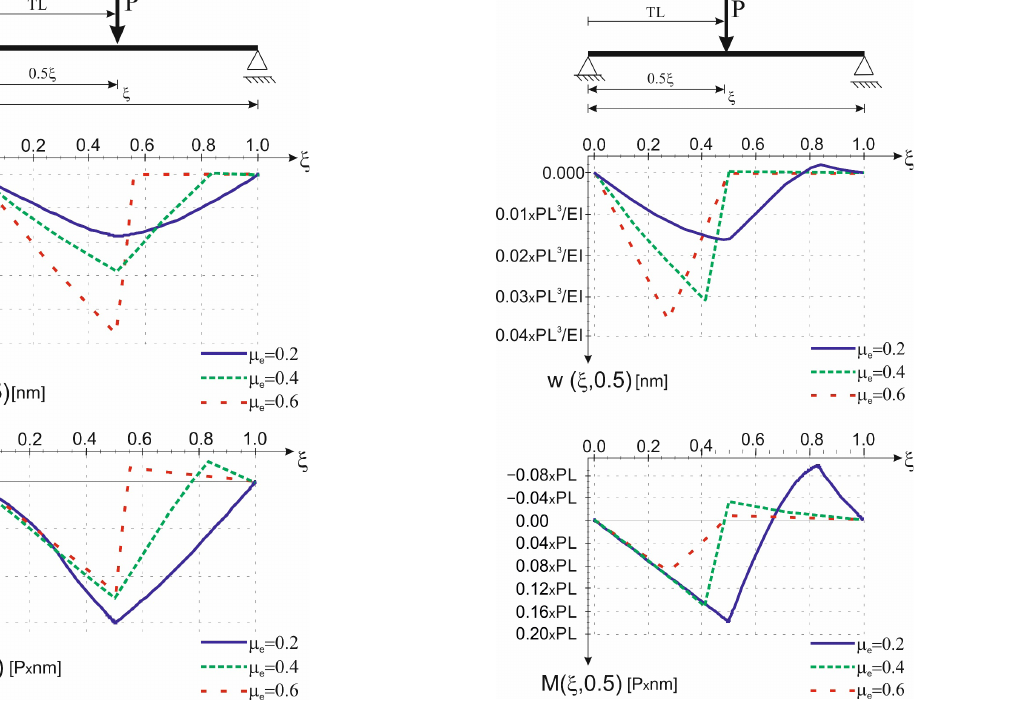
Figure 4: Stress gradient model. Displacement and bending moment of the beam for 0.5 T = , 0.05 g η = .